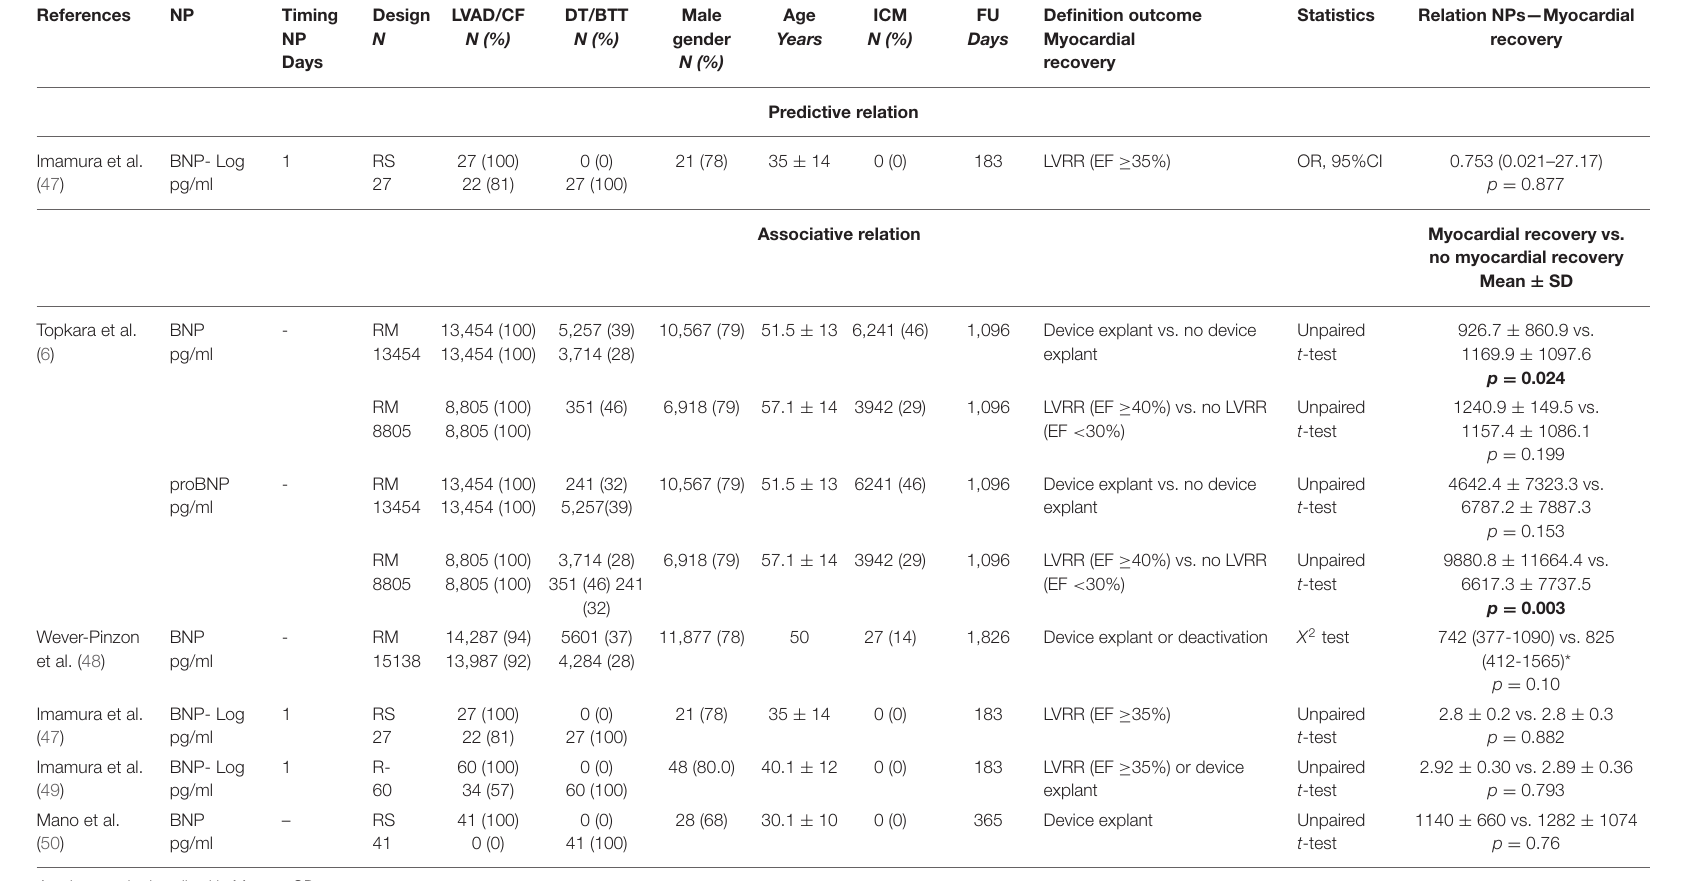
TABLE 5 | Baseline characteristics and outcomes of included studies for left ventricular (LV) myocardial